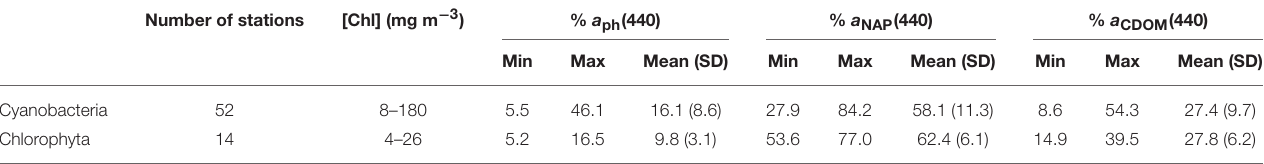
TABLE 4 | Identified phytoplankton groups with relation to contributions of a ph (440), a NAP (440), and a CDOM (440) to the total non-water absorption. Number of